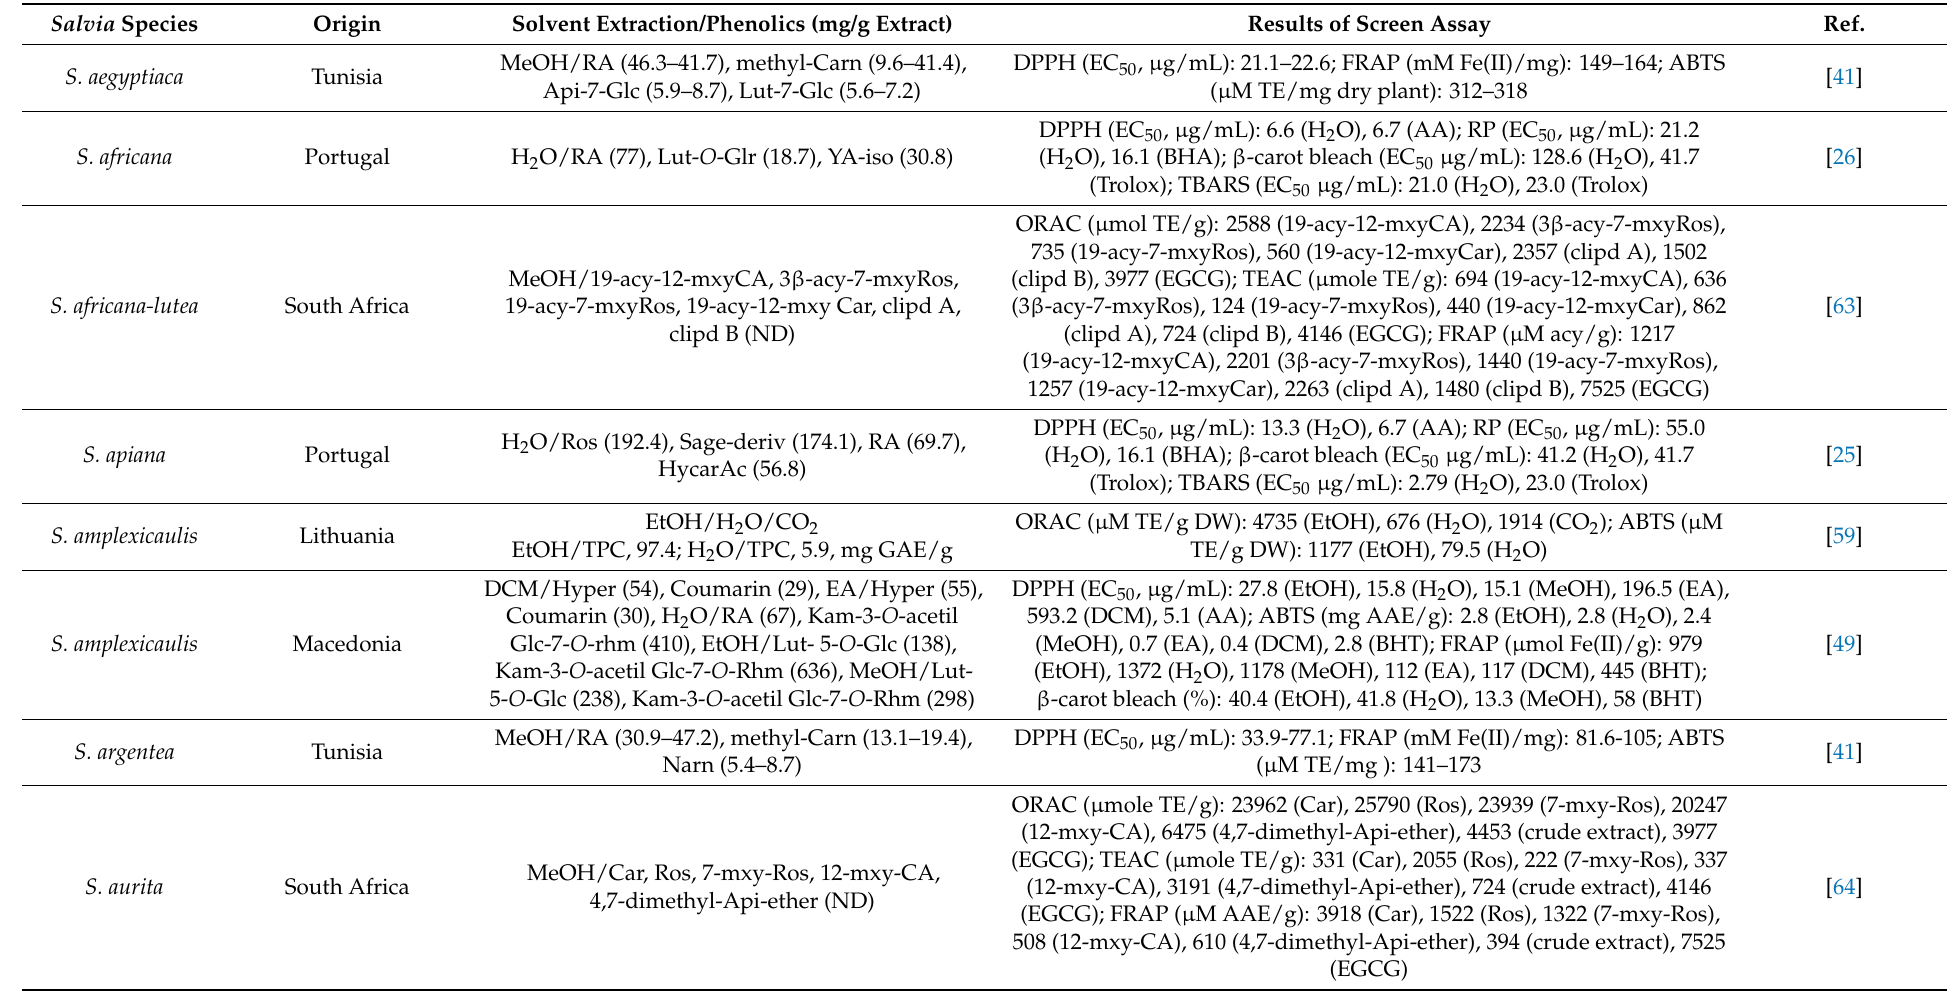
Table 1. Antioxidant properties of phenolic rich extracts of distinct Salvia species (in vitro